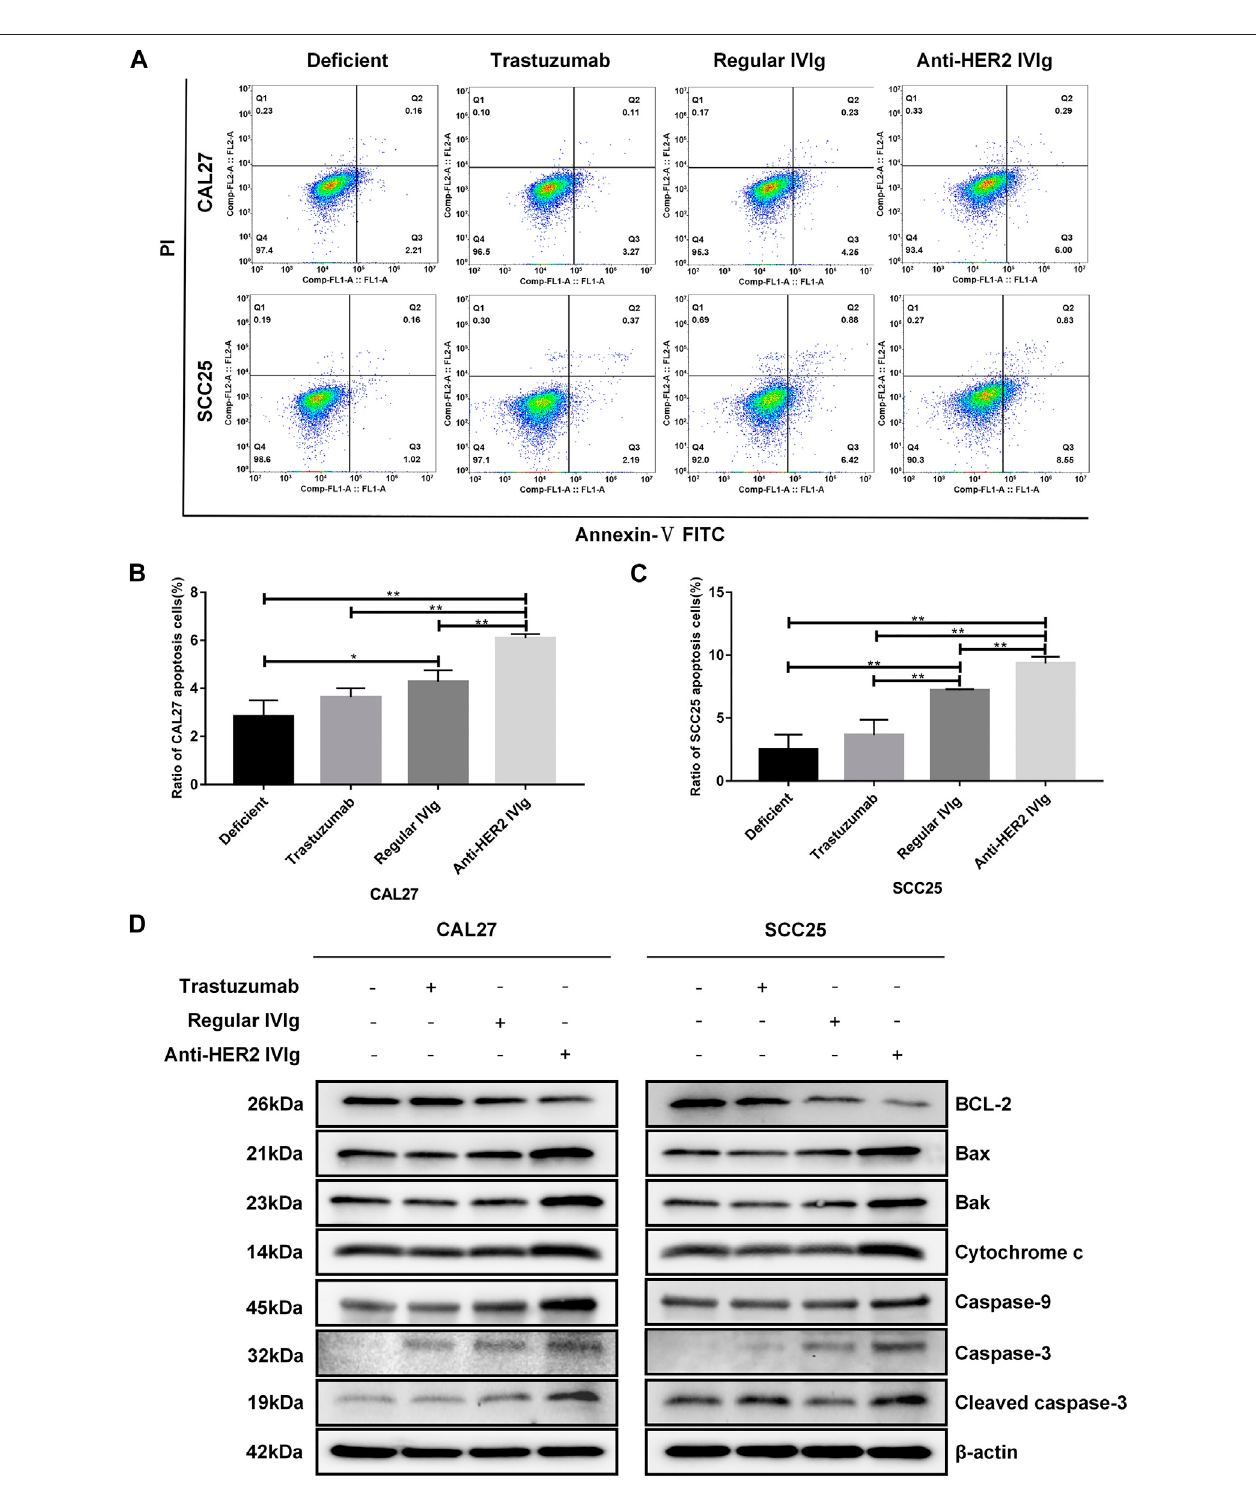
FIGURE 5 | The effects of anti-HER2 IVIg on OSCC cells apoptosis. (A – C) Apoptosis of CAL27 and SCC25 cells treated for 48 h with anti-HER2 IgG-de fi cient plasmaonly,200 μ g/mltrastuzumab,5 mg/mlregularIVIg,and5 mg/mlanti-HER2IVIg,respectively.Thedatawereexpressedasmean ± SDinproportionofapoptotic cells. (D) CAL27cells and SCC25 cellswere treated for48 h withanti-HER2 IgG-de fi cient plasmaonly, 200 μ g/ml trastuzumab, 5 mg/ml regular IVIg, and 5 mg/ml anti- HER2IVIg,respectively;theexpressionofapoptosis-relatedfactors,includingBcl-2,Bax,Bak,cytochromec,caspase-9,caspase-3,andcleavedcaspase-3,was then determined by Western blot with β -actin as a reference. De fi cient, anti-HER2 IgG-de fi cient plasma; IVIg, intravenous immunoglobulin; * p < 0.05; ** p < 0.01.